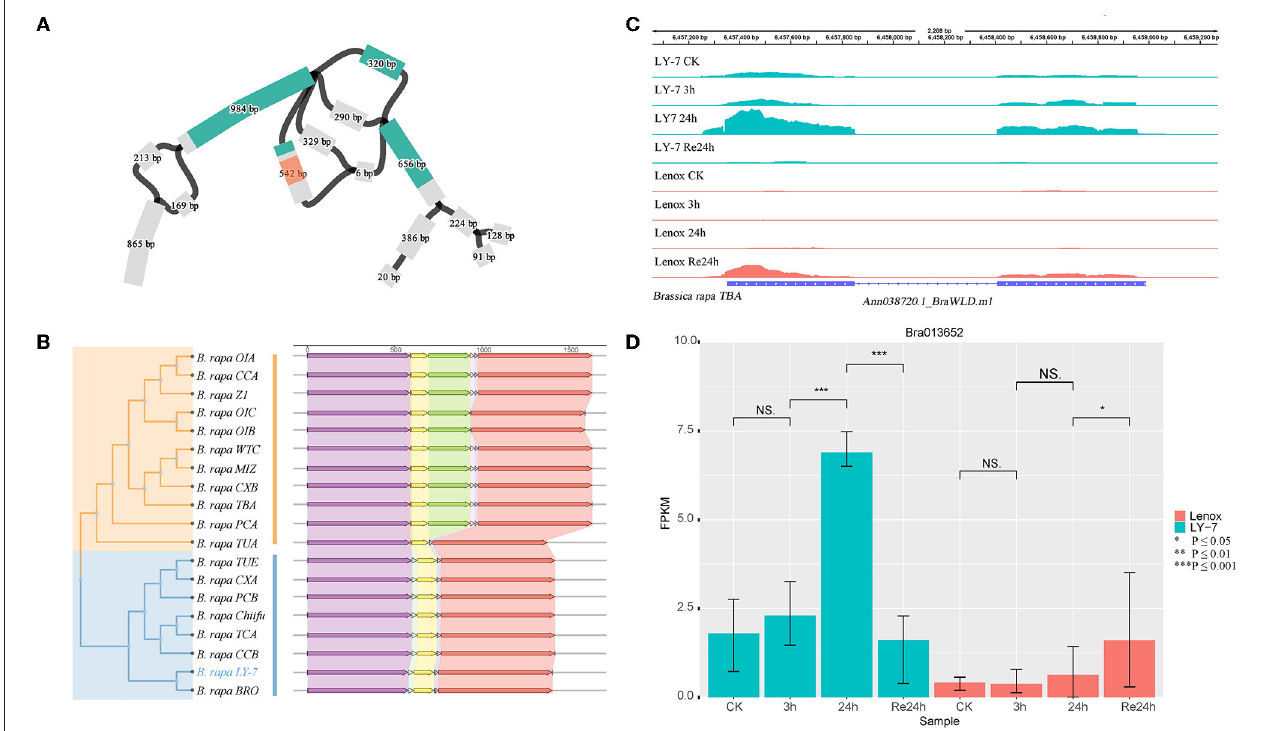
FIGURE 6 | Structure variant of BrANS3 in B. rapa “Longyou-7” genome. (A) BLAST hit of BrANS3 gene of “Longyou-7” genome (blue) and a 240 bp of structural variation (red transparent) detected within the graph-based pan-genome; (B) Neighbor-joining tree clustering and the gene structure characteristics of BrANS3 gene; (C) Coverage of RNA-Seq reads in the region of BrANS3 gene in “TBA” (From Tibet, China) genome and their abundance; (D) The differential expression of BrANS3 between “Longyou-7” and “Lenox” cultivars within 48h.